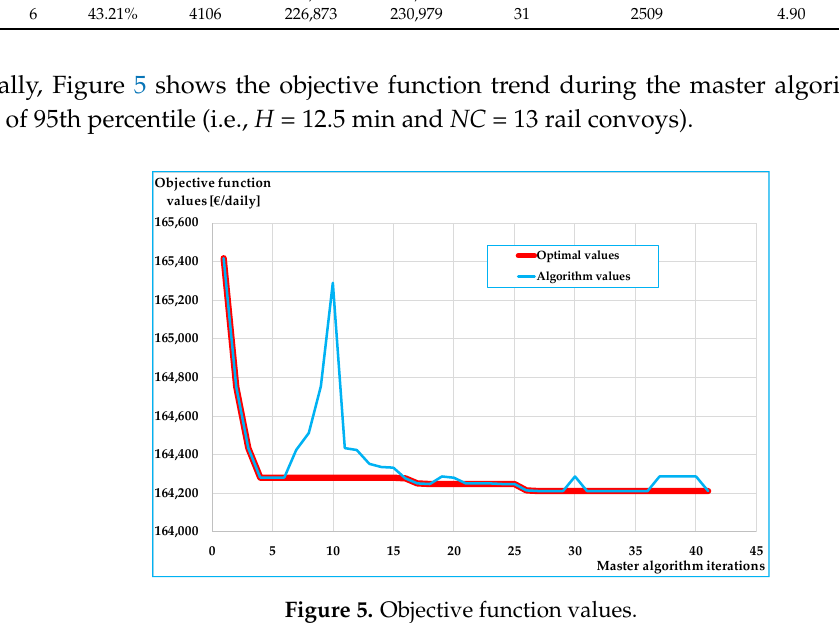
Table 10. Solution algorithm performance in the case of 97.5th percentile.